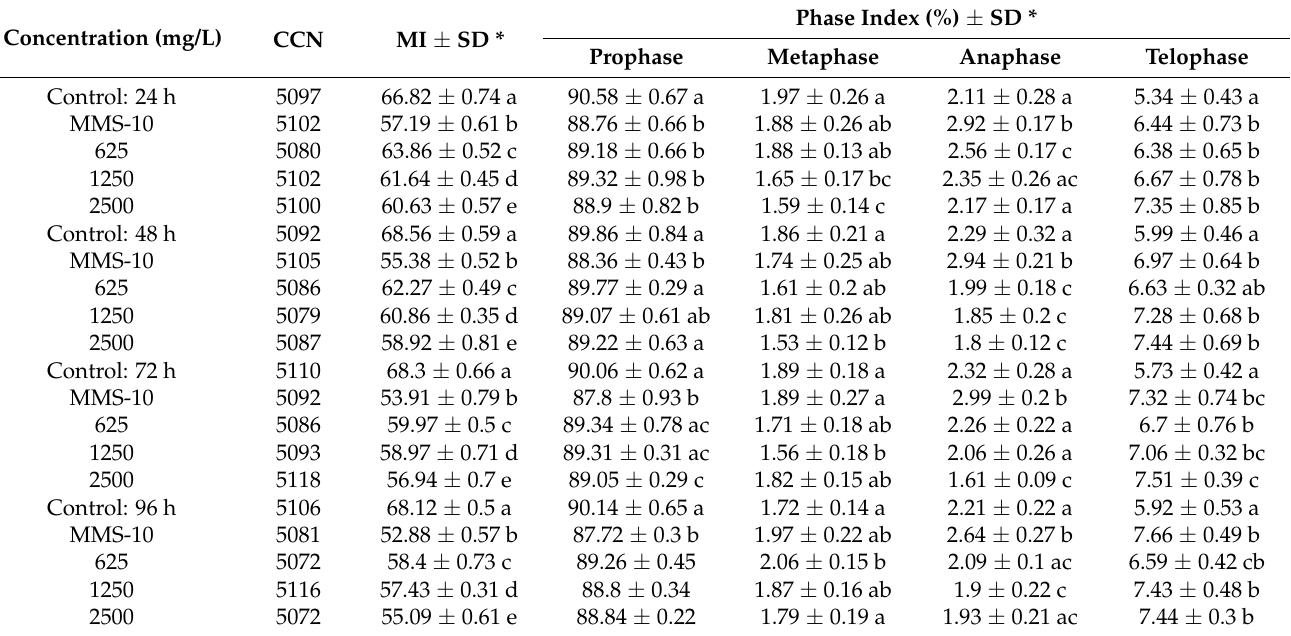
Table 1. Effect of FLB on mitotic index and mitotic phase indices in A. cepa roots.